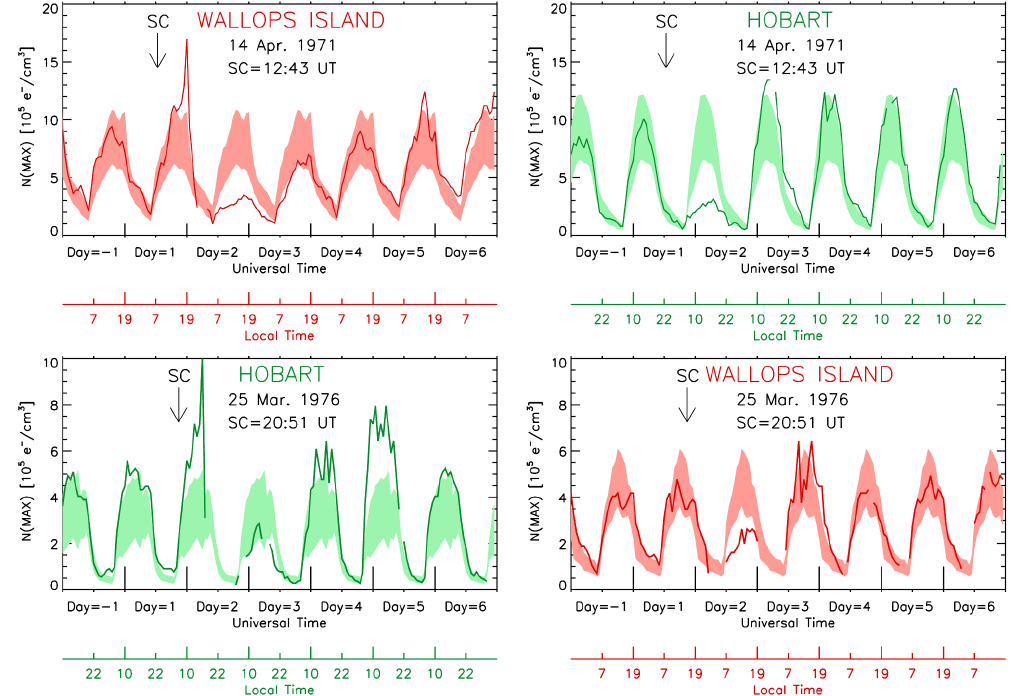
Fig. 2. Examples of ionospheric storms at Wallops Island and Hobart. The top panel illustrates an SC time that occurred during the daytime at Wallops Island and at nighttime at Hobart. The lower panel shows an example of the reverse case. Shadings give the pattern of the monthly mean with one standard deviation ( ± σ) about that